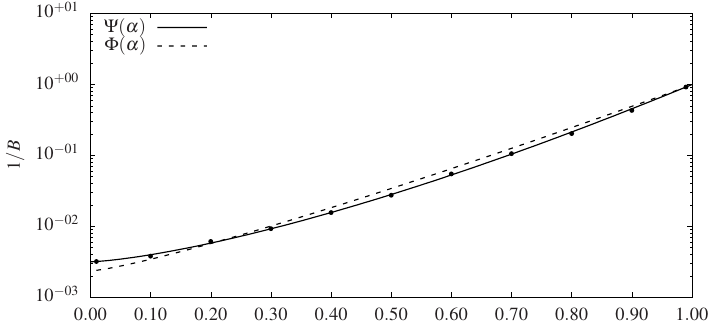
Figure 3 - Early values of 1/B for which the Tweedie densities are calculated correctly, in the direction of increasing z , for each α , and adjusted curves Φ ( α ) (dashed line) and Ψ ( α ) (solid line).